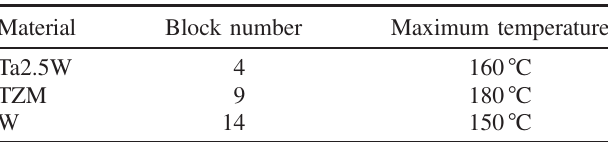
TABLE III. Maximum temperatures expected in the different BDF target materials for the most critical blocks.